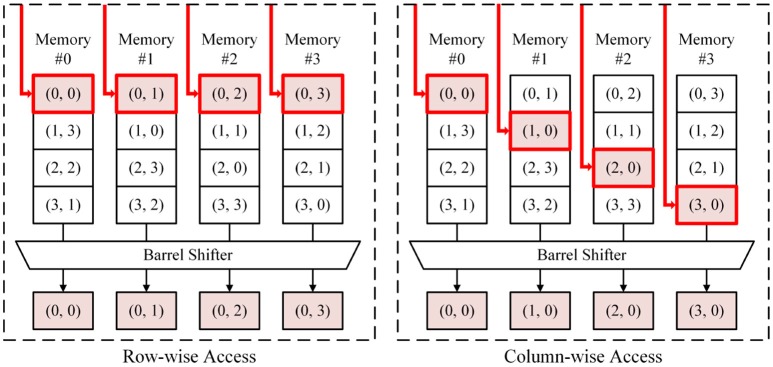
Transposable addressing scheme (C = 4, B = 4).